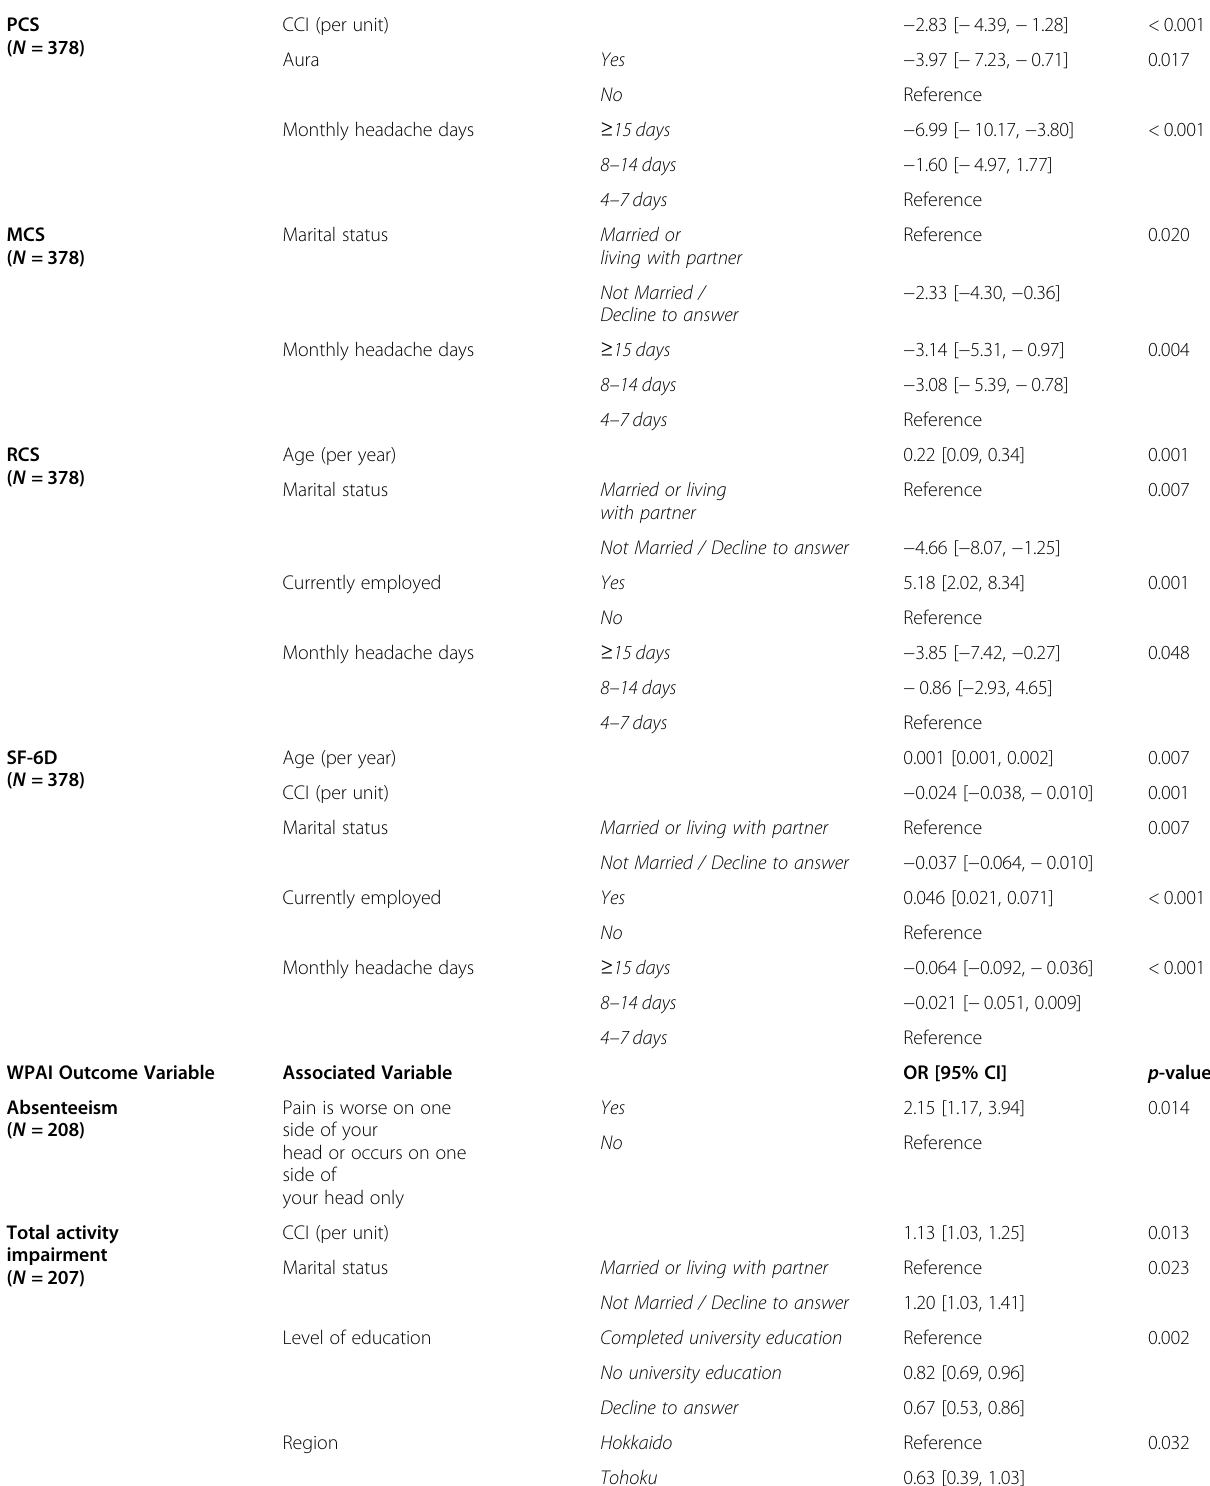
Table 2 Multivariate analyses of factors associated with humanistic and economic burden among Japanese migraine patients HRQoL Outcome